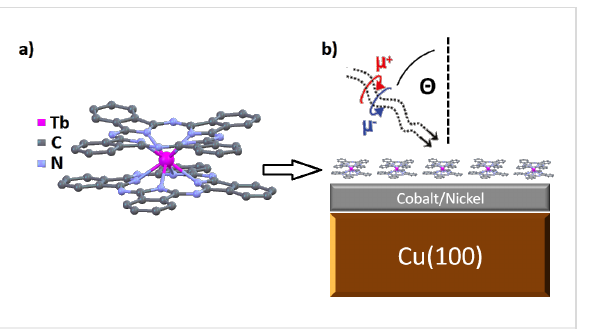
Figure 1: (a) The TbPc 2 molecule, consisting of two parallel phthalo- cyanine planes with the Tb ion centred in between and (b) a schematic illustration of the sample studied.